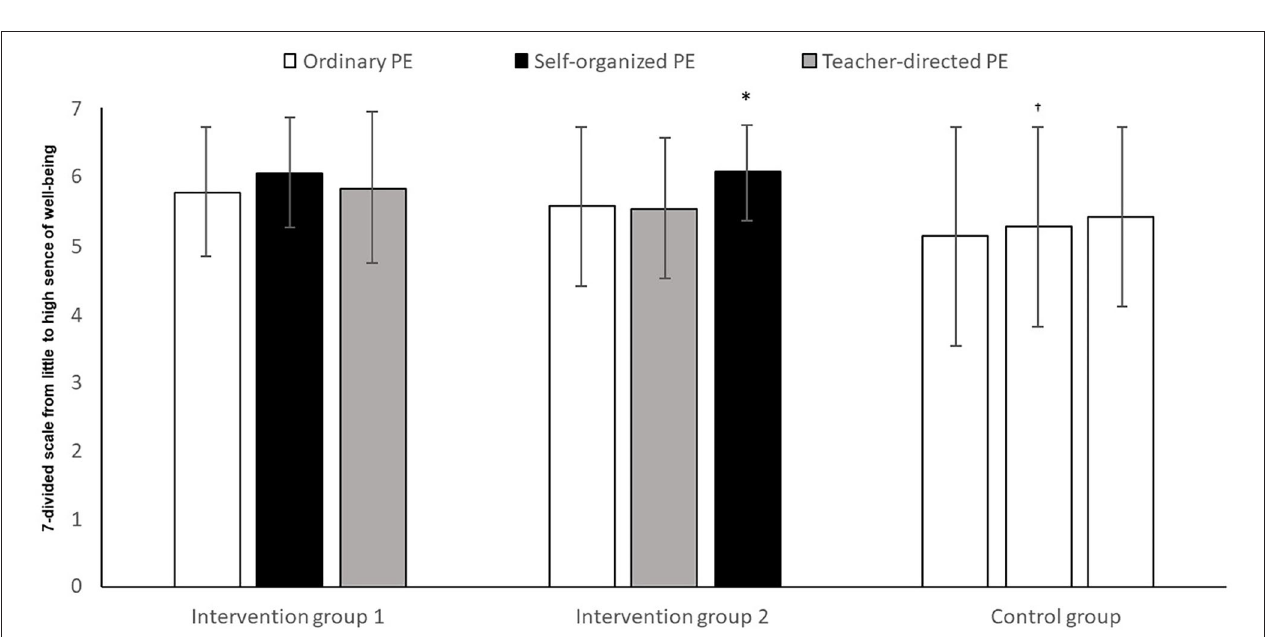
FIGURE 4 | Perception of mastery among pupils after three time periods of ordinary PE, teacher-directed PE, or self-determined PE.